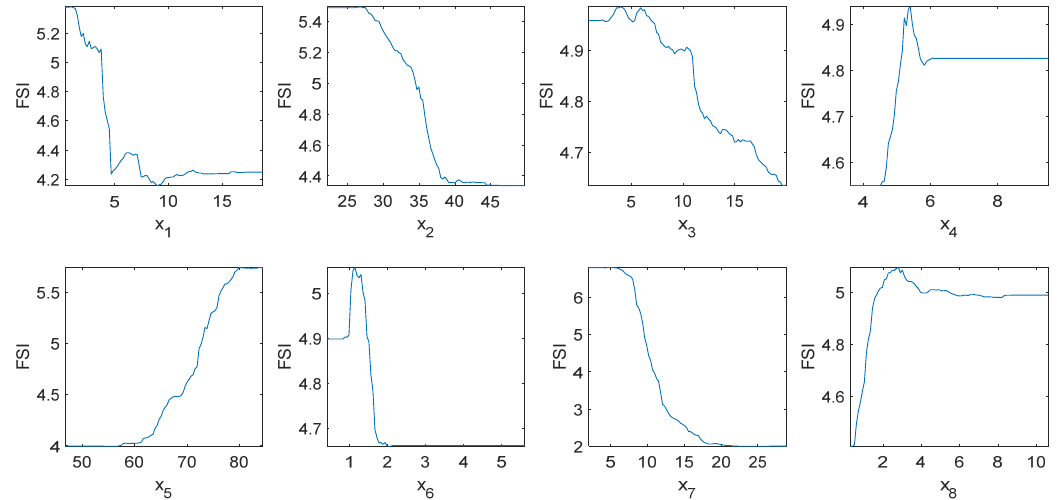
Figure 10. Partial dependence plots for predictors of the free swelling index of coal.